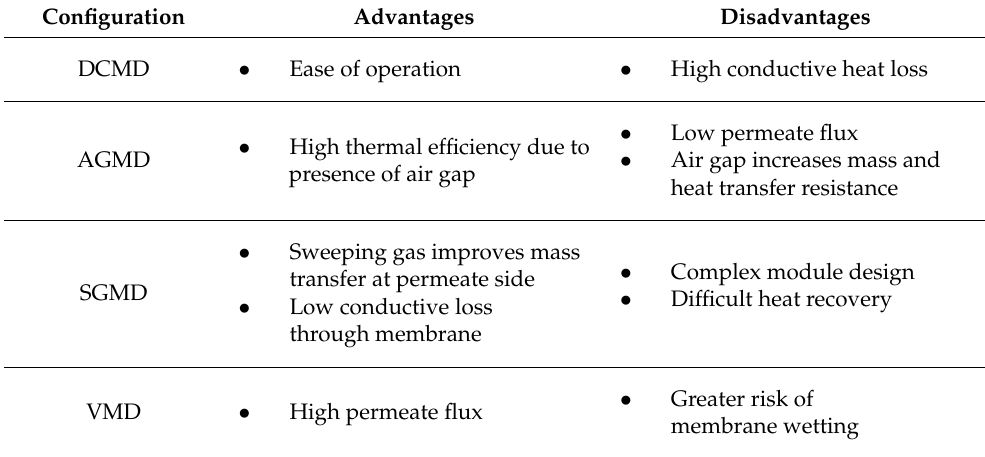
Table 1. Advantages and disadvantages of each of the four conventional membrane distillation configurations [68,69].